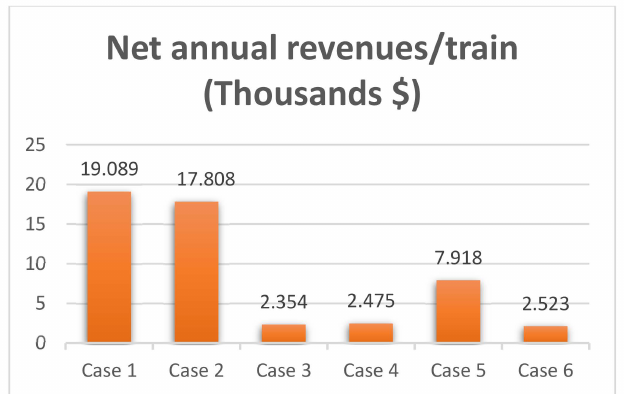
Figure 5. Comparison of net annual revenues/train (Thousands USD) for the six cases when using the electric brake regenerative technique.